Question: Summarize what this figure shows in one sentence.
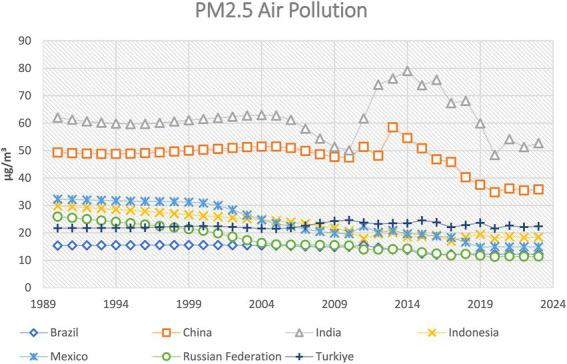
Answer: Annual trend of PM2.5 in E7 nations during the study span.